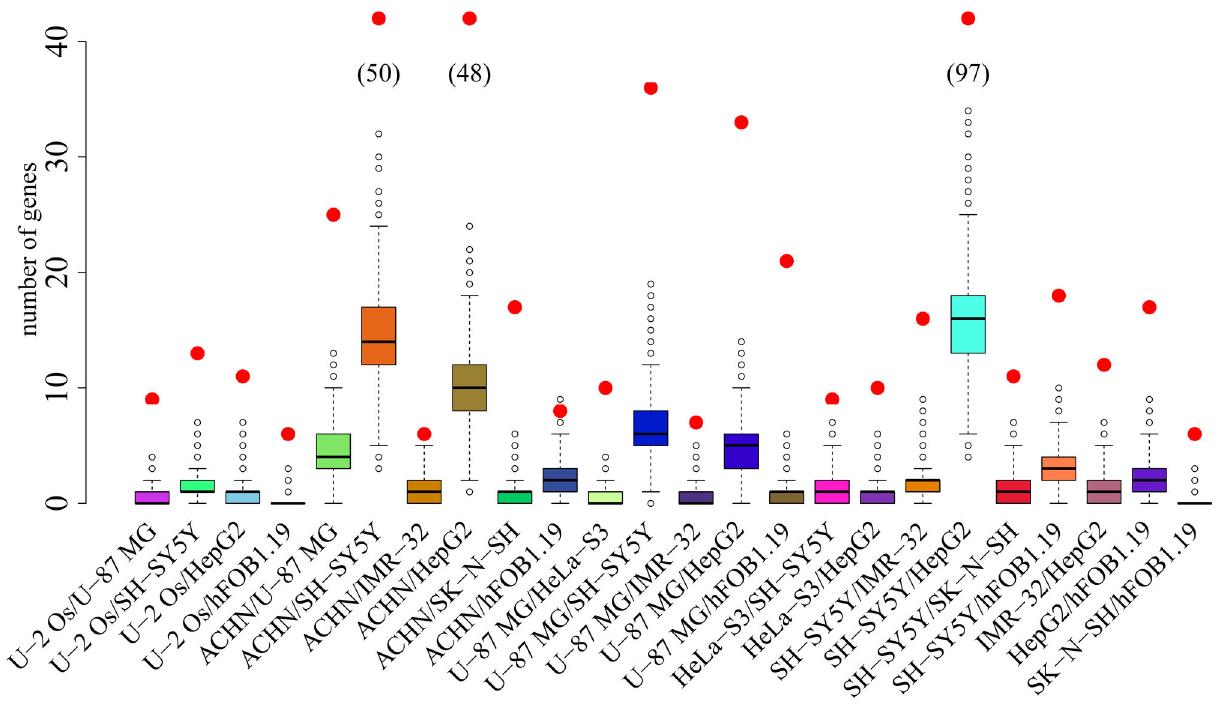
Figure 2. Overlaps of differentially expressed genes between cell lines. Numbers of genes that differ in expression after RUNX2 overexpression in two cell lines (red dots), and distribution of such overlaps between sets of the same numbers of random genes expressed in the cell lines. If the number of genes overlapping between a pair of cell lines was smaller than five, it is not